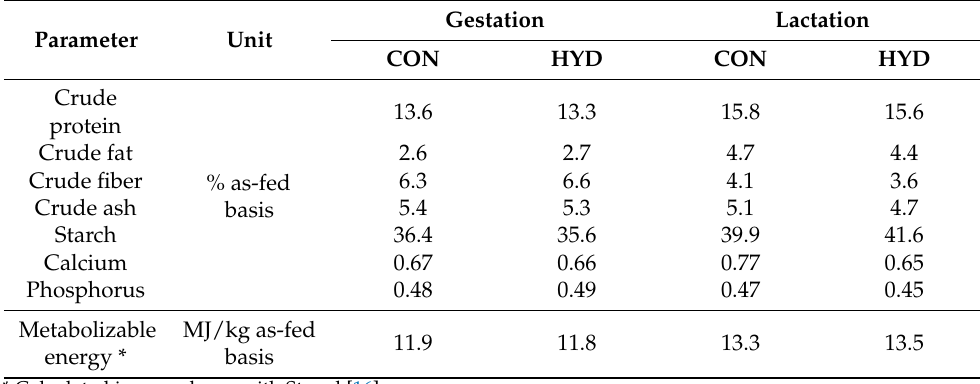
Table 2. Chemical composition of the experimental diets.